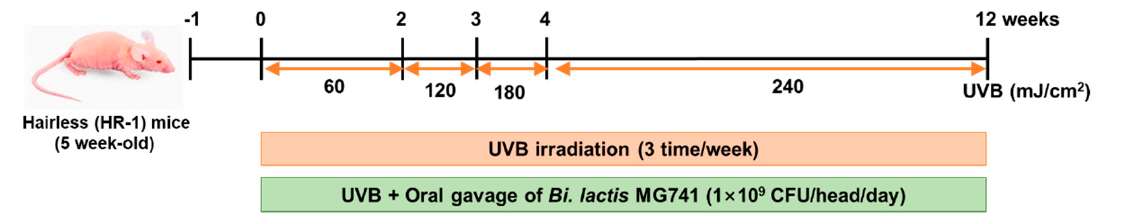
Figure 1. Animal experiment procedure of UVB irradiation on HR − 1 mice. After adaptation, the dorsal skin of the HR − 1 mice was irradiated to UVB (290 to 320 nm) at one minimal erythema dose (MED, 60 mJ/cm 2 ) for two weeks, two MED (120 mJ/cm 2 ) for one week, three MED (180 mJ/cm 2 ) for one week, and four MED (240 mJ/cm 2 ) for the last eight weeks.